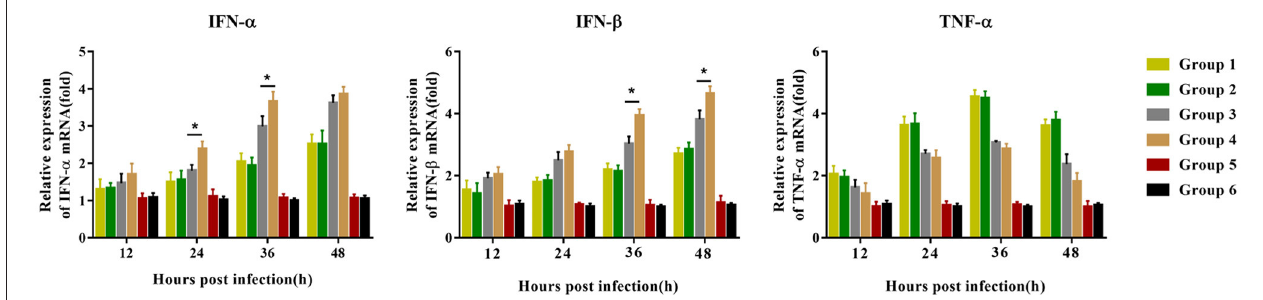
FIGURE 7 | Immune-related gene expression in PBMCs re-stimulated with JXA1 (MOI of 0.05 TCID 50 per cell) in vitro . PBMCs were collected from all piglets 28 dpv. Harvested PBMCs were incubated with JXA1 (MOI of 0.05 TCID 50 per cell) for 1h at 37 ◦ C and then cultured in a fresh medium. Cells were collected for the detection of mRNA expression of immune-related genes using qRT-PCR with specific primers at the indicated hours post-infection. Statistical significance is denoted by * p <